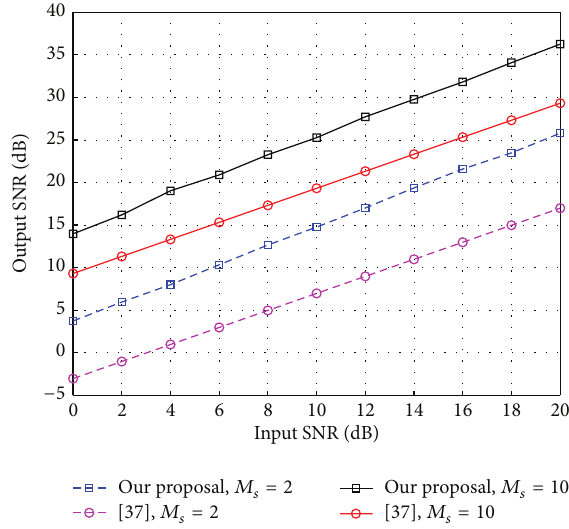
Figure 5: Output SNR versus input